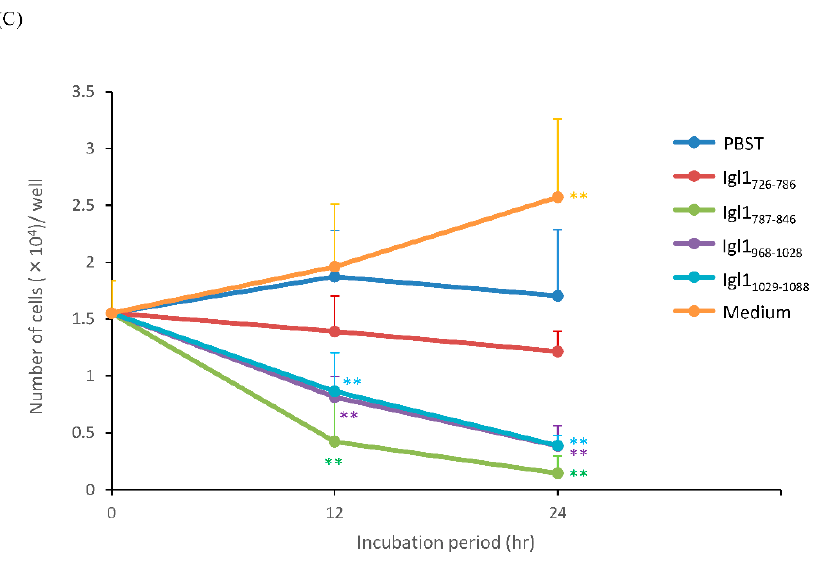
Figure 4. Cytotoxicity of Igl1 fragment proteins against Caco-2 cells. Caco-2 cells were cultured with 1 µ M Igl1 fragments and incubated at 37 ◦ C for 12 or 24 h. ( A ) Purities and amounts of Igl1 fragments were confirmed by SDS-PAGE using a NuPAGE gel, with 1 µ g of each protein run in the gel. Lane 1: Igl1 726-786 , Lane 2: Igl1 787-846 , Lane 3: Igl1 968-1028 , Lane 4: Igl1 1029-1088 , Lane 5: BSA. ( B ) Images of Caco-2 cells incubated with Igl1 fragments in a 96-well plate for the indicated periods. Images were taken with an EVOS-XL microscope. Bars indicate 100 µ m. ( C ) Number of Caco-2 cells remaining in the well after incubations for 0, 12 and 24 h. Data are the mean + SD from 5 independent studies. ** p < 0.01 vs. PBST (Dunnett test).